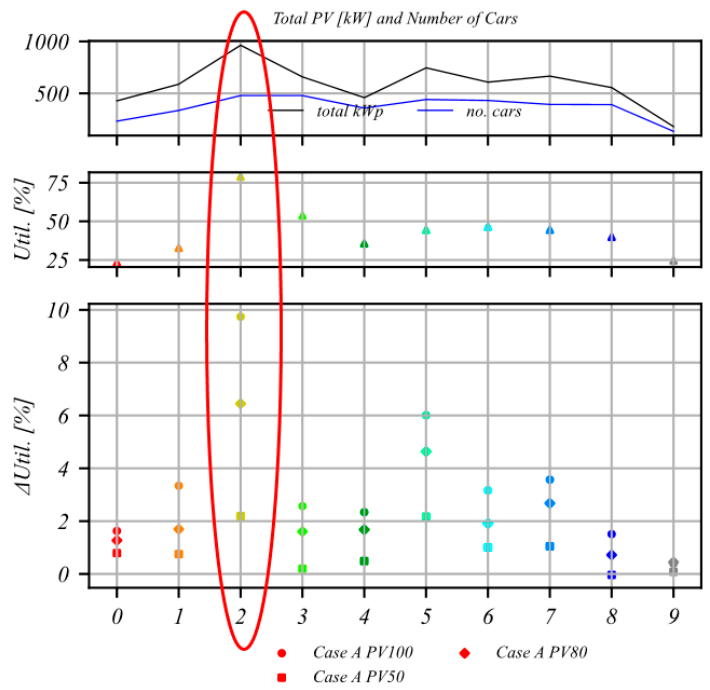
Figure 8. Impact of the demand function on the utilization on grid level for all 10 transformers (0–9 and colored) with its PV installation size and number of cars in its subgrid.